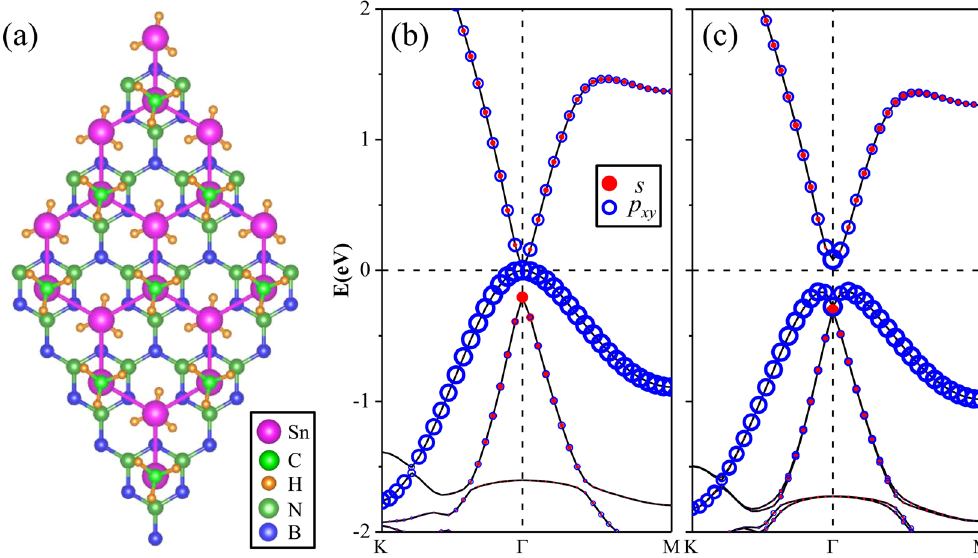
Figure 5. ( a ) Top view of atomic structure of 6%-strained SnCH 3 on h -BN substrate. Corresponding band structures of 6%-strained SnCH 3 / h -BN heterostructure ( b ) without SOC and ( c ) with SOC. The radius of red dots and blue circles indicate the weight of s and p xy orbitals. The Fermi level is set to